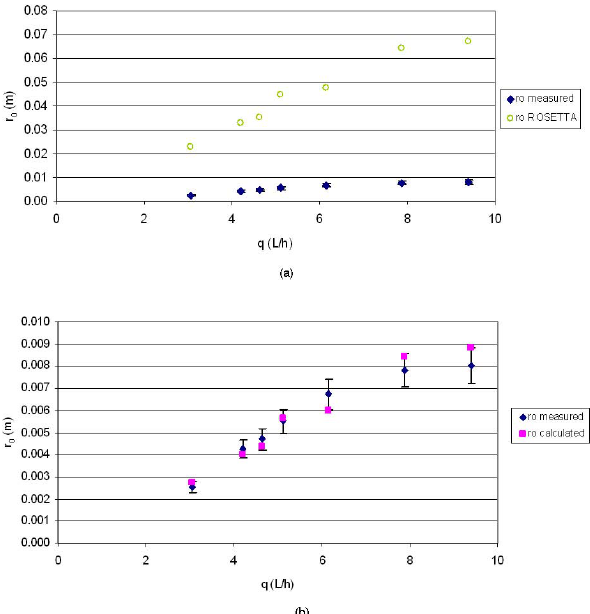
Fig. 5. Evolution of the equivalent spherical cavity radius ( r 0 equiv.) measured and estimated from ROSETTA values and those obtained with a different K s .